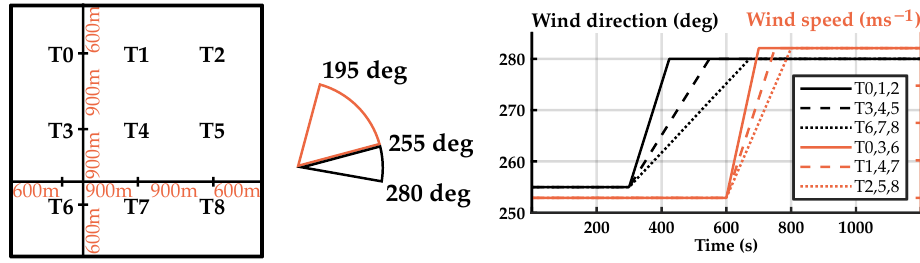
Figure 4. The left figure depicts the wind farm layout which is used in Sections 3.2 and 3.3, along with the main wind directions in both cases. The right figure depicts the transition between the flow variables for the different turbines during the FLORIDyn reference